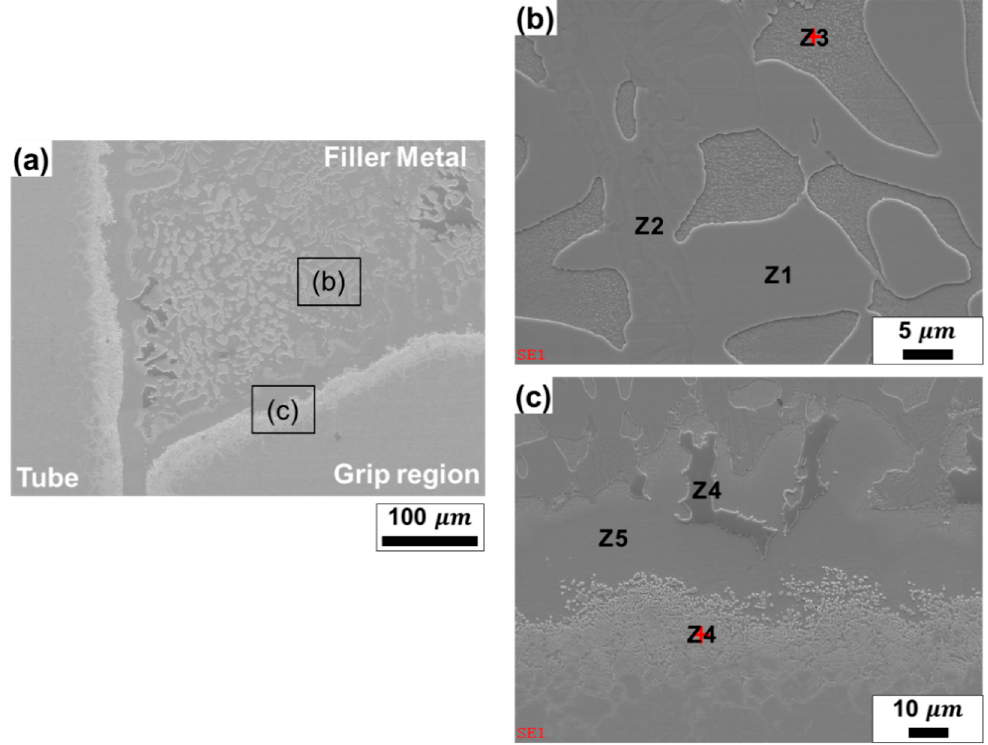
Figure 4. ( a ) SEM image of the brazed region; ( b , c ) enlarged SEM images of the areas marked in ( a ).